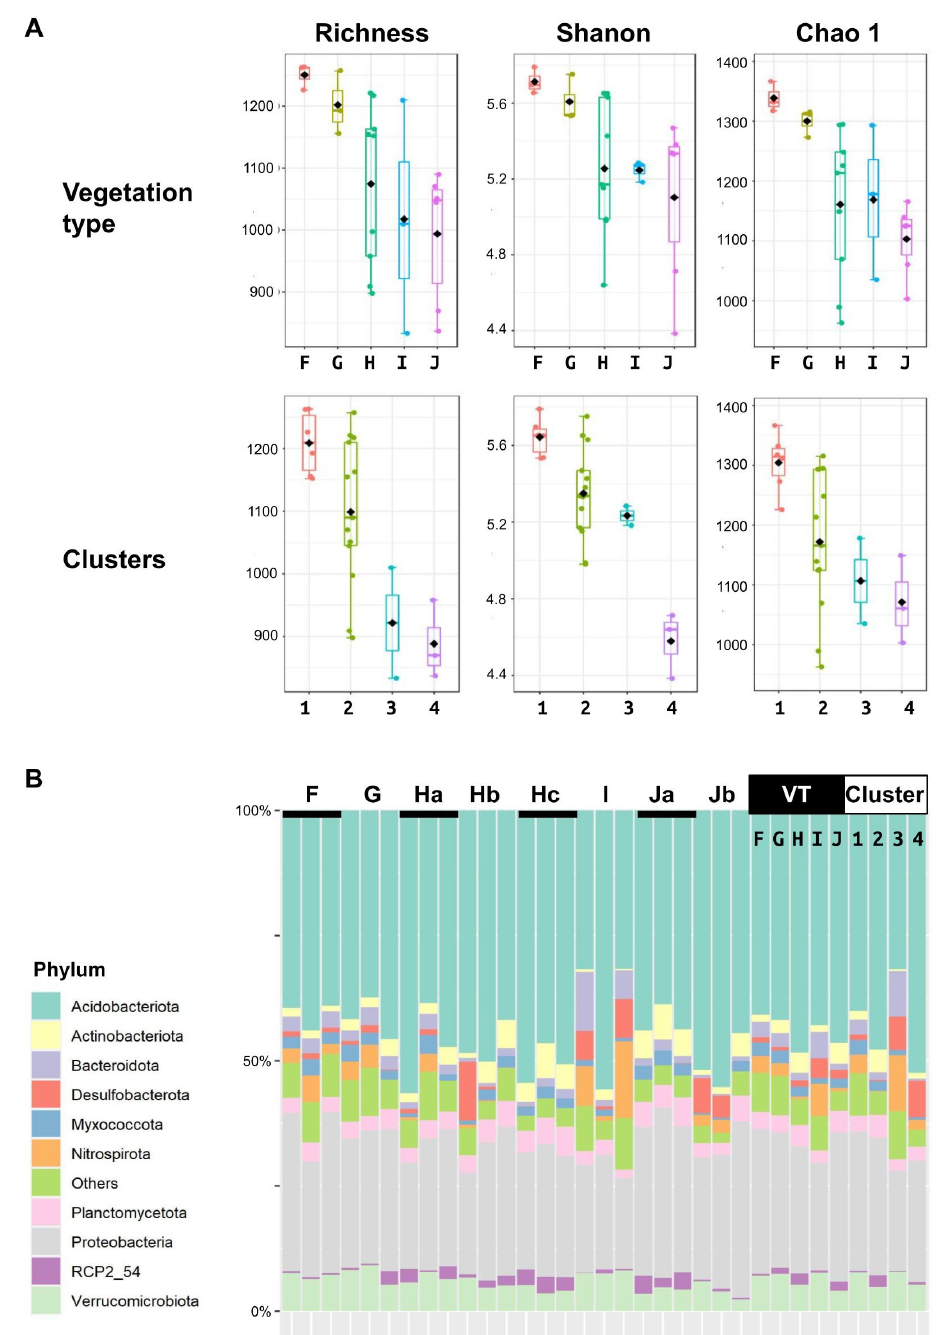
Figure 2. Bacterial diversity in YYL soil samples. ( A ) Alpha diversity (operational taxonomic units (OTU) richness, Shannon index, Chao 1 index) for samples from each vegetation type (upper panel) and principal coordinate analysis (PCoA) cluster (lower panel). ( B ) Bacterial community compositions at the phylum level. Community compositions are depicted for individual sample, vegetation type (VT, F to J) average or PCoA cluster (Cluster, 1–4) average. The 10 most abundant phyla are depicted separately; others were merged into “others”.